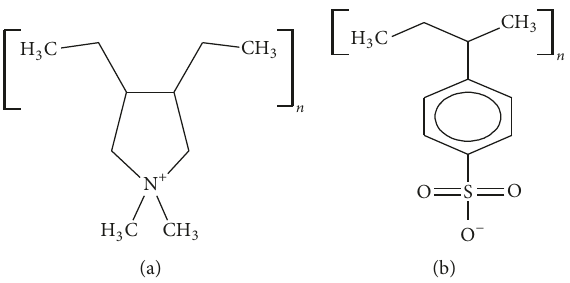
Figure 1: Chemical structures of (a) poly(diallyldimethylammo- nium chloride (PDADMAC) and (b) polystyrene sulfonate